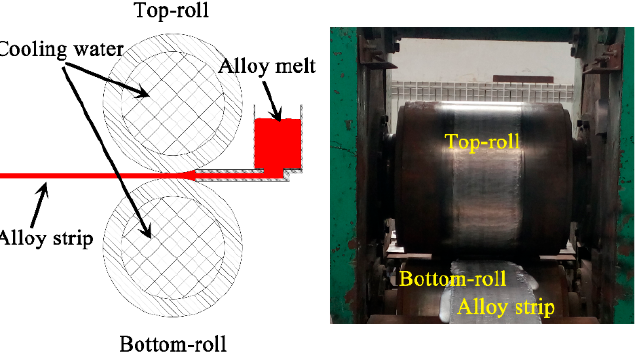
Figure 2. Schematic illustration of TRC technique and physical map of TRC experimental device.